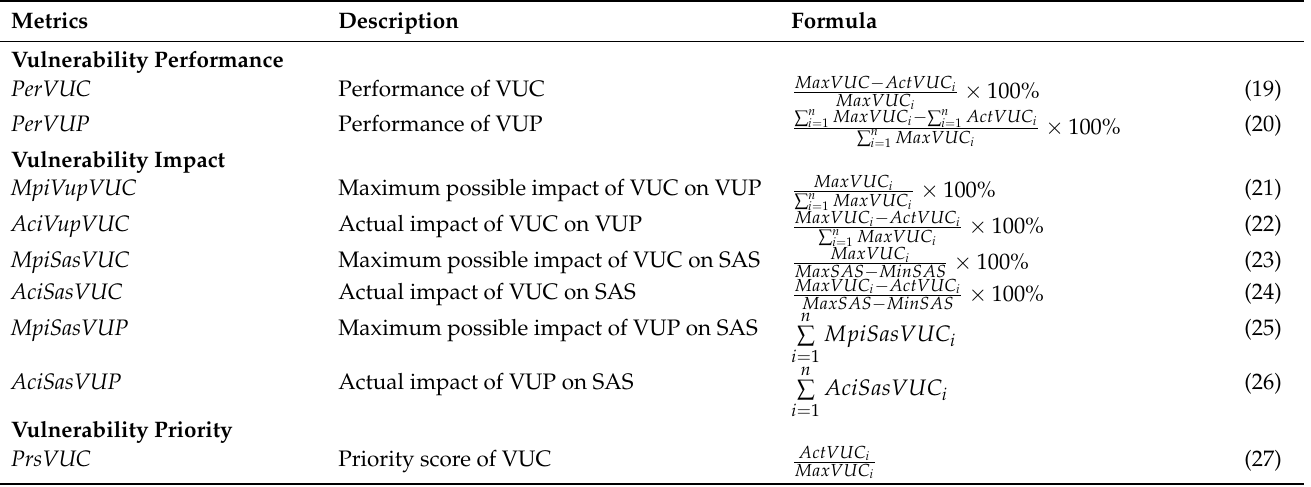
Table 7. Summary of vulnerability